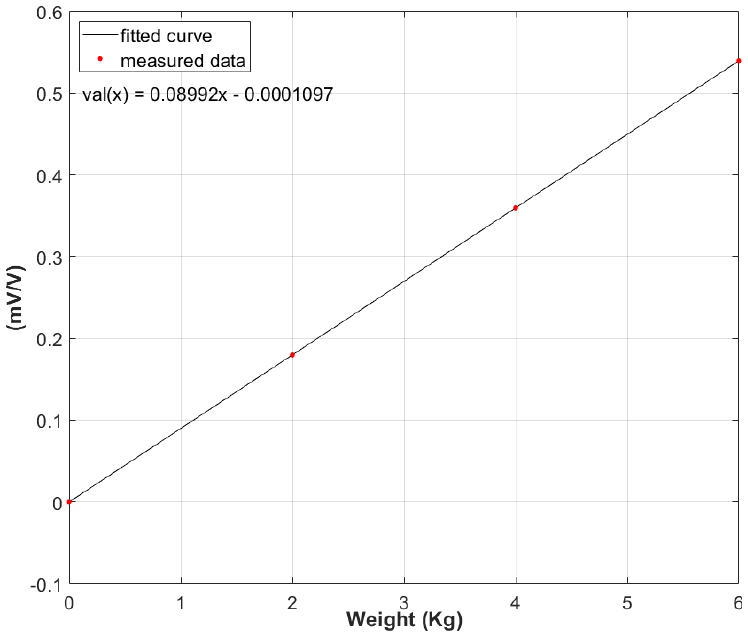
Figure A1. Calibration curve for the one-component load